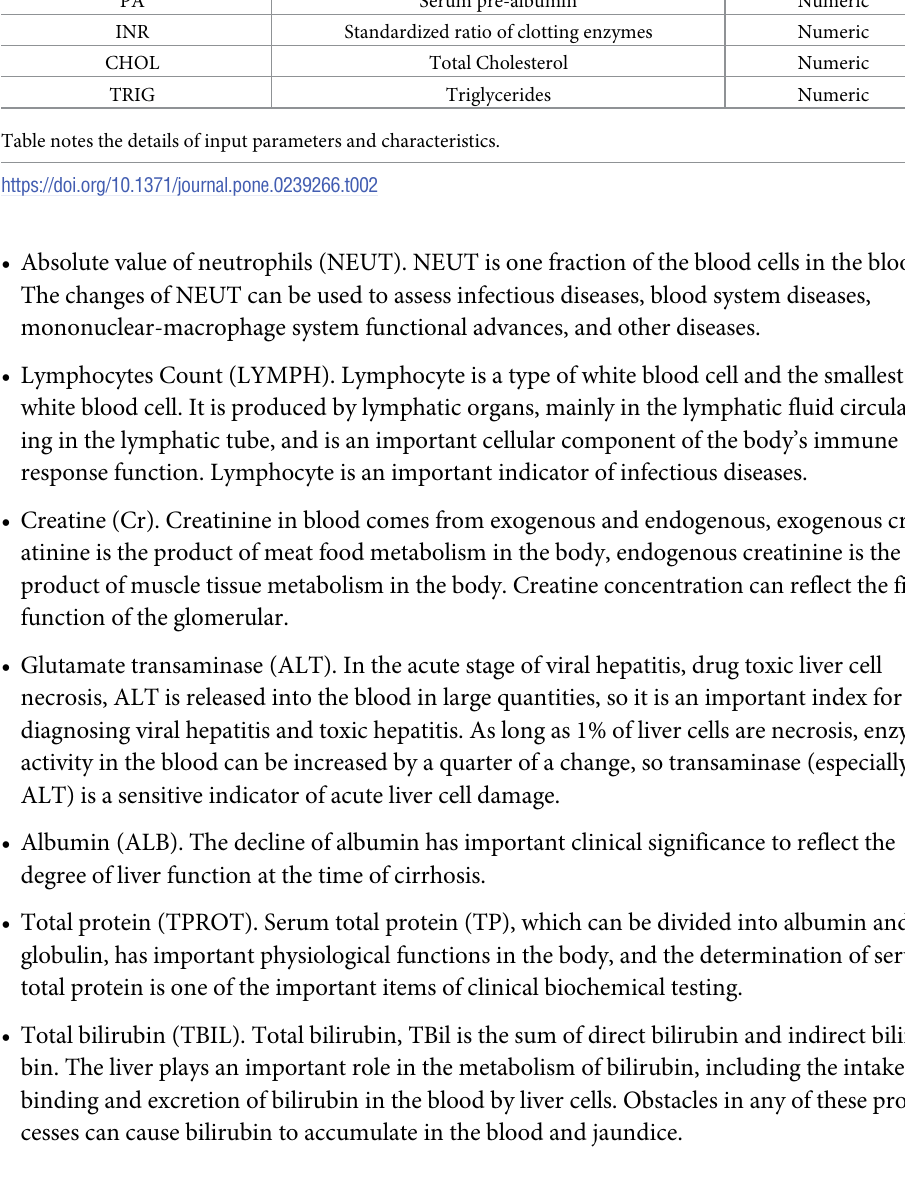
Table notes the details of input parameters and